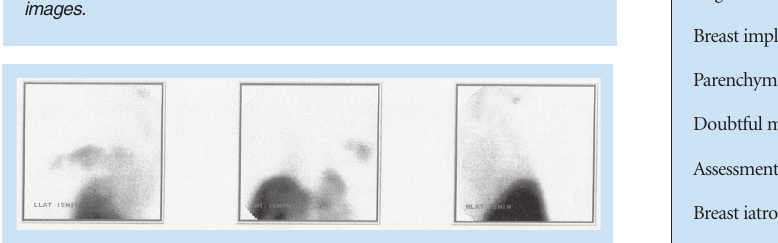
Fig. 1. Normal biodistribution of 99m Tc-MIBI SM on both anterior and lateral images.